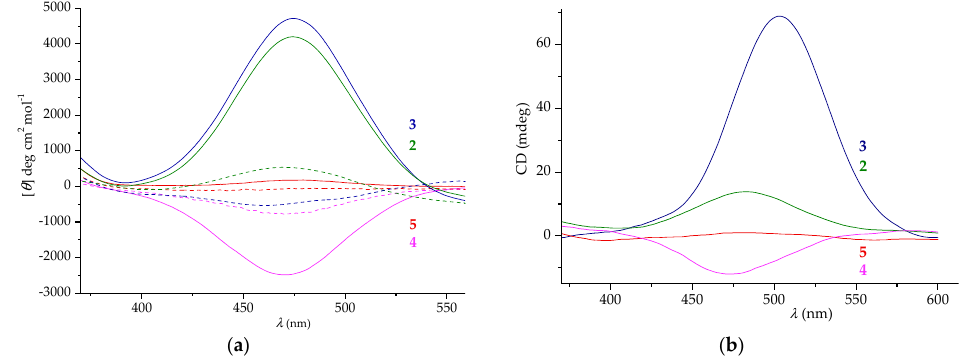
Figure 11. The Cotton effects in chirality-organized ferrocene peptides 2 – 4 ( a ) in solution (CH 2 Cl 2 , c = 1 × 10 − 3 M, ( ⎯ ) and CH 2 Cl 2 , c = 1 × 10 − 3 M containing 20% of DMSO (–—–)) and ( b ) in solid state (2 mg in 200 mg KBr).